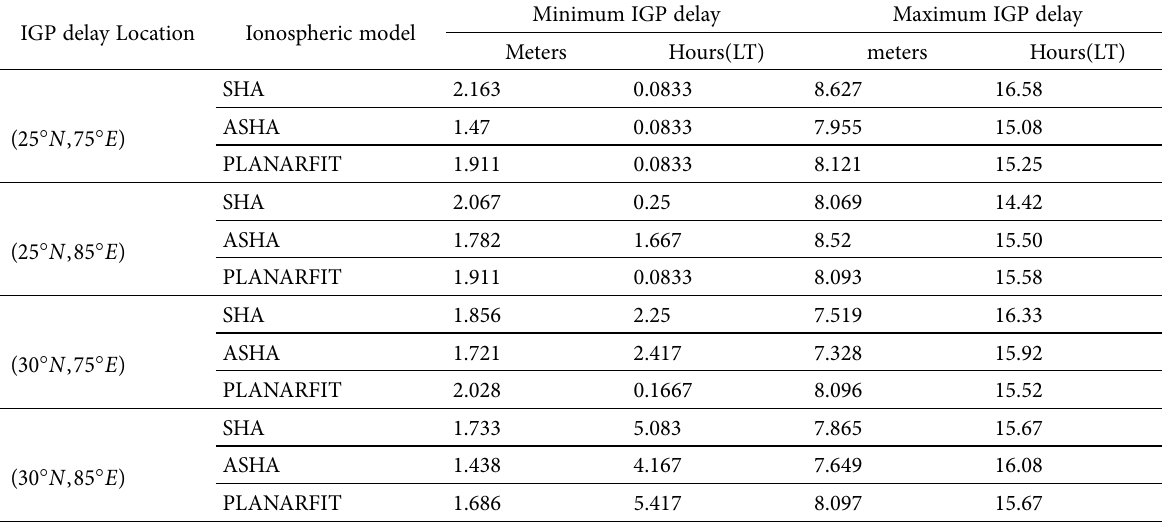
Table 2. IGP delays observed at various IGP locations during the disturbed day (July 23, 2004).